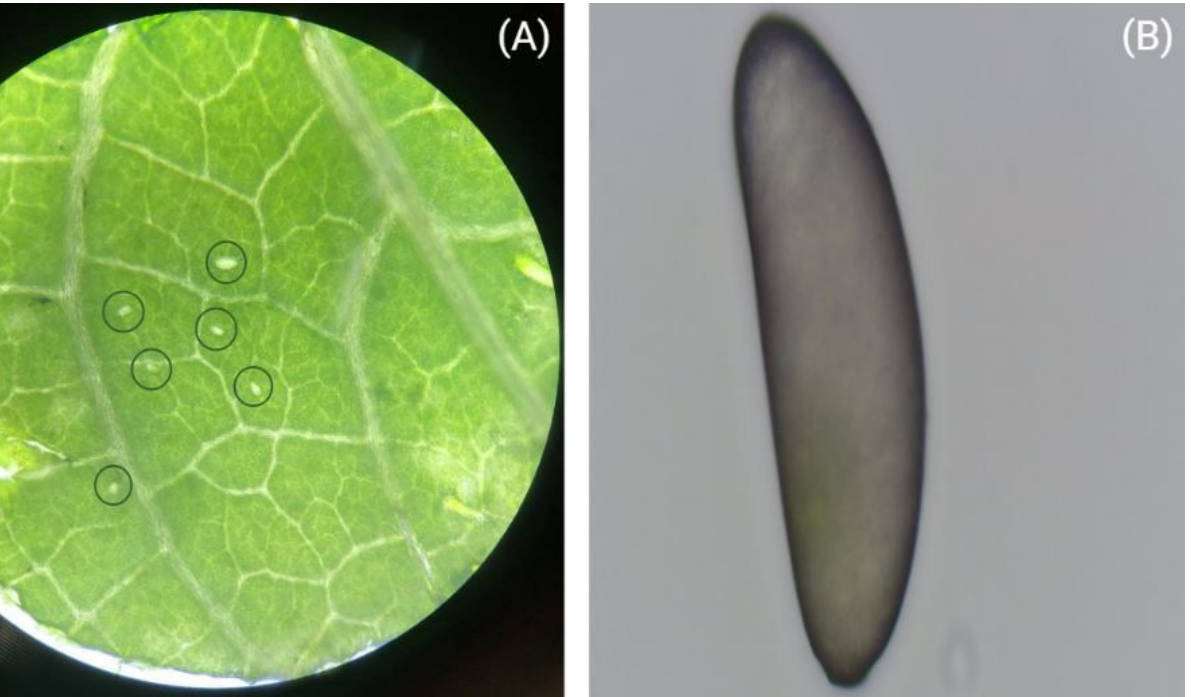
Figure 1. Thrips tabaci eggs inserted into a bean leaf ( A ) and an egg excavated from plant tissue ( B ). 2.1. Egg Collection from Virgin and Mated Females of L1 and T